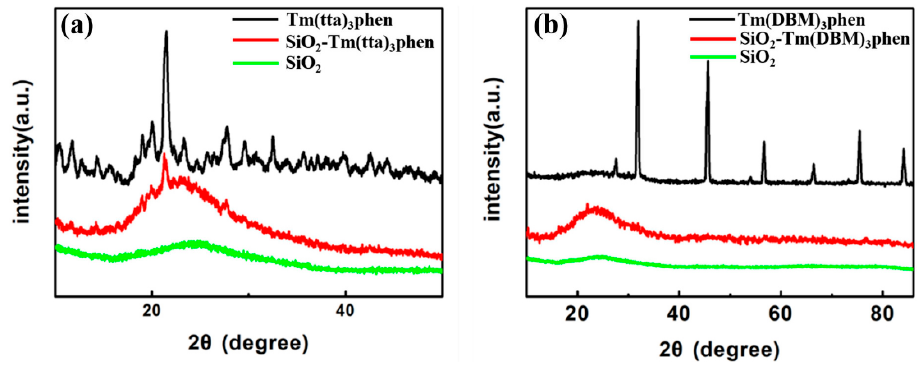
Figure 2. X-ray diffraction (XRD) patterns of ( a ) Tm(TTA) 3 phen, SiO 2 -Tm(TTA) 3 phen, and Nano-SiO 2 ; ( b ) Tm(DBM) 3 phen, SiO 2 -Tm(DBM) 3 phen, and nano-SiO 2 .